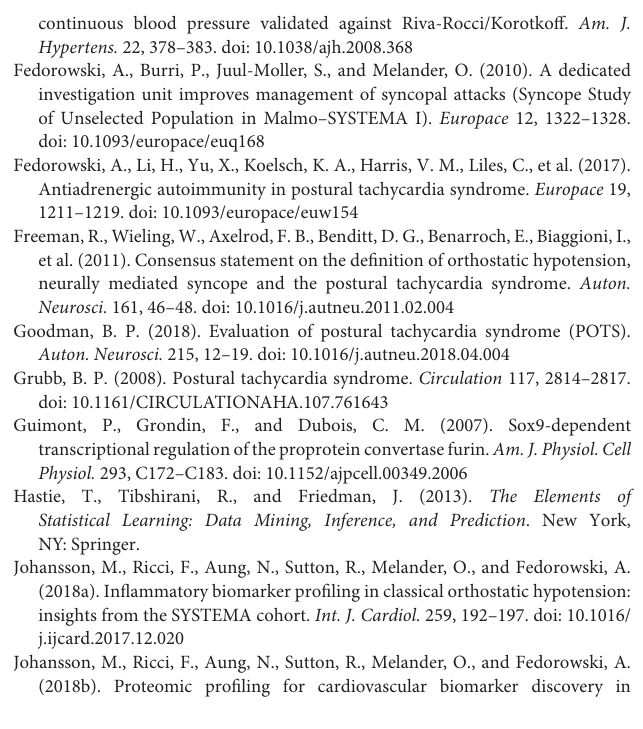
FIGURE S1 | Heatmap visualization of the proteomics data showing the hierarchical clustering of 48 biomarkers by POTS status. FIGURE S2 | Quantile regression analysis. Furin regressed on 25th, 50th and 75th quantiles of delta HR max. The x axis is the quantile of delta HR max (black dots in the plots represent the regression coefficient at 0.25, 0.5 (median) and 0.75). The gray bands are the 95% CI of the quantile regression coefficient. The horizontal red and the two horizontal dotted lines are the ordinary least square (OLS) linear regression lines. What you can see here is that 95% CI of the coefficients from quantile regression overlaps widely with OLS lines indicating that Furin does not have differing effects on different quantiles of delta HR max. TABLE S1 | Immuno-oncology panel: biomarker list. TABLE S2 | Comparison of baseline characteristics between the whole cohort and complete cases without missing